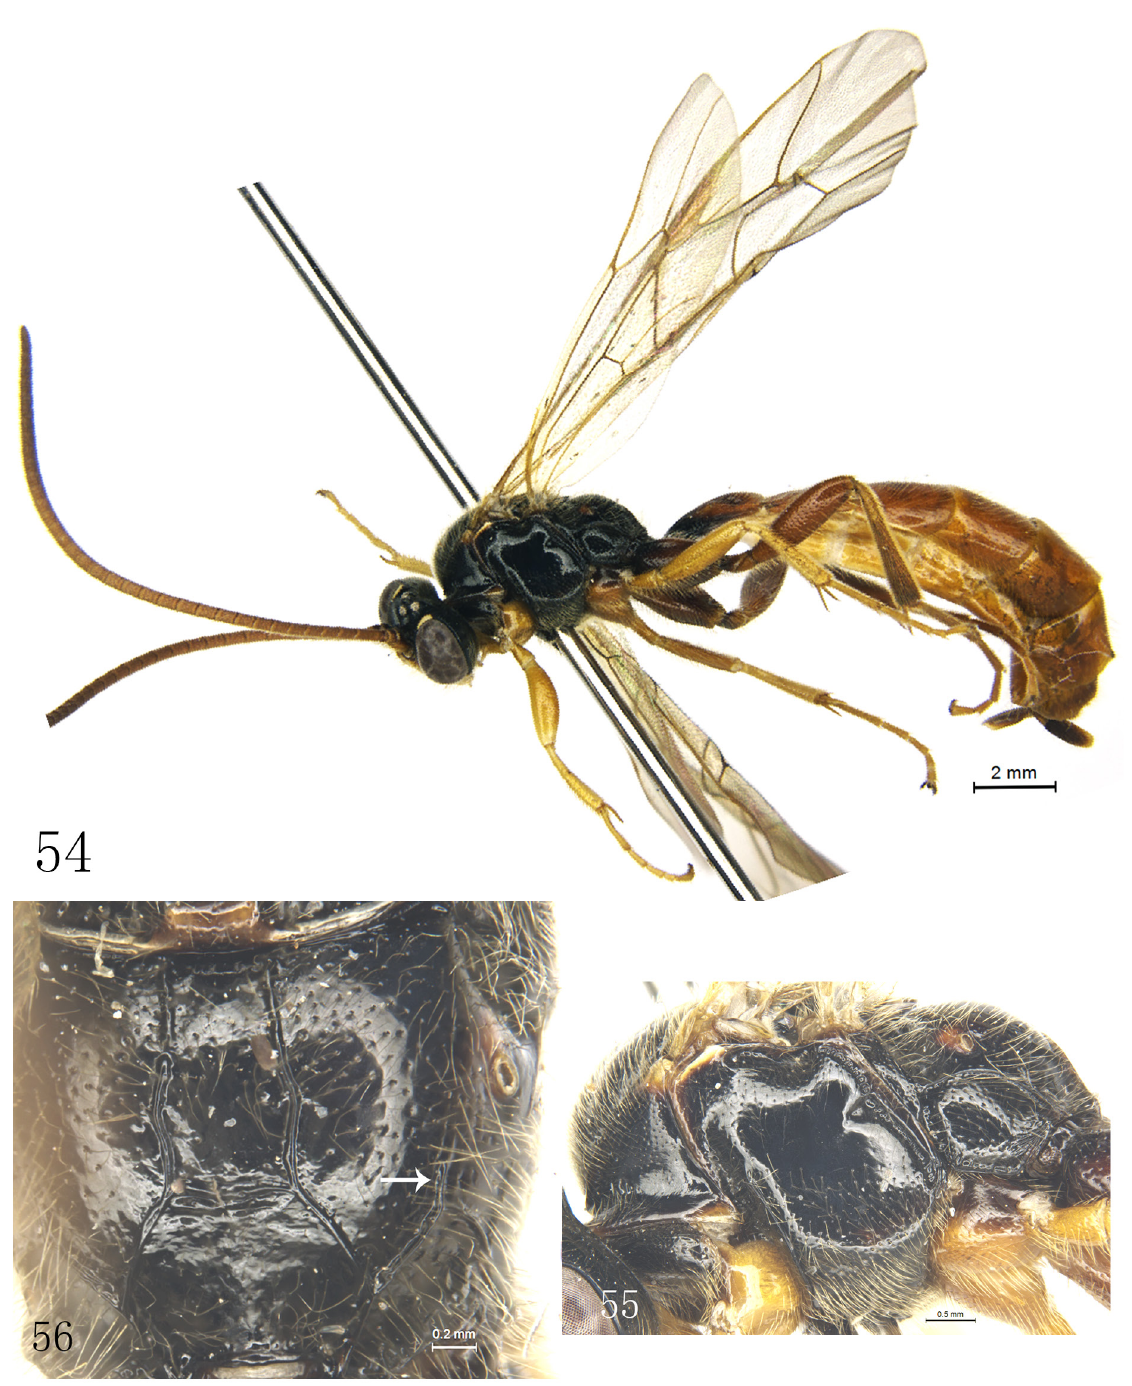
Figs 54–56. Ctenopelma melanothoracicum Sheng, 2009, holotype, ♀ (GSFGPM). 54 . Habitus, lateral view. 55 . Mesosoma, lateral view. 56 .